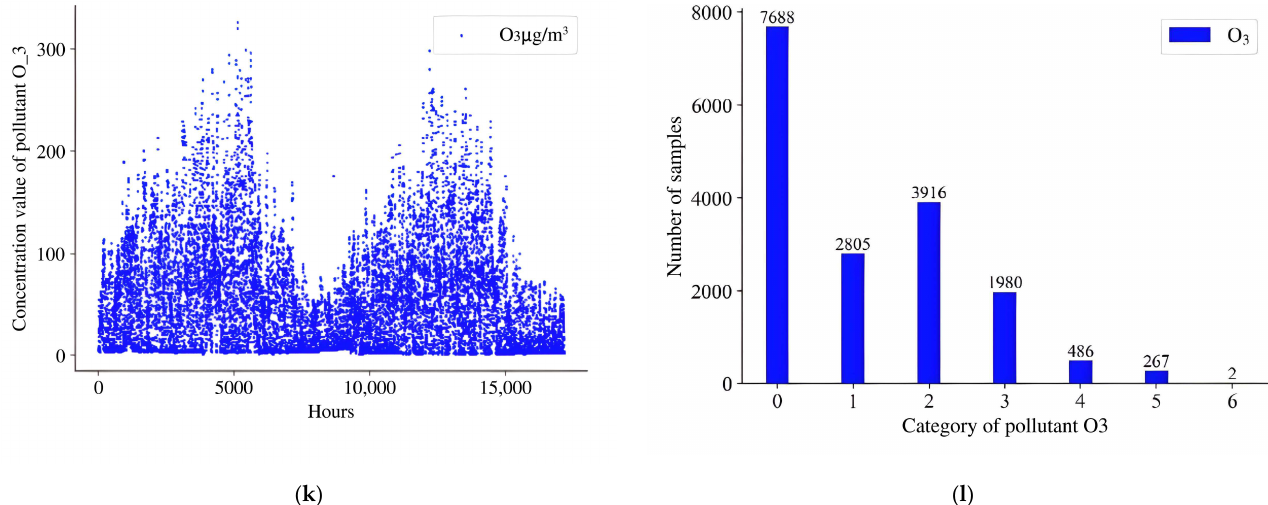
Figure 3. Sca(cid:308)er plots of pollutant concentrations and bar charts of each grade of air pollution. ( a , b ): PM 10 ; ( c , d ): PM 2.5 ; ( e , f ): SO 2 ; ( g , h ): NO 2 ; ( i , j ): CO; ( k , l ): O 3 .